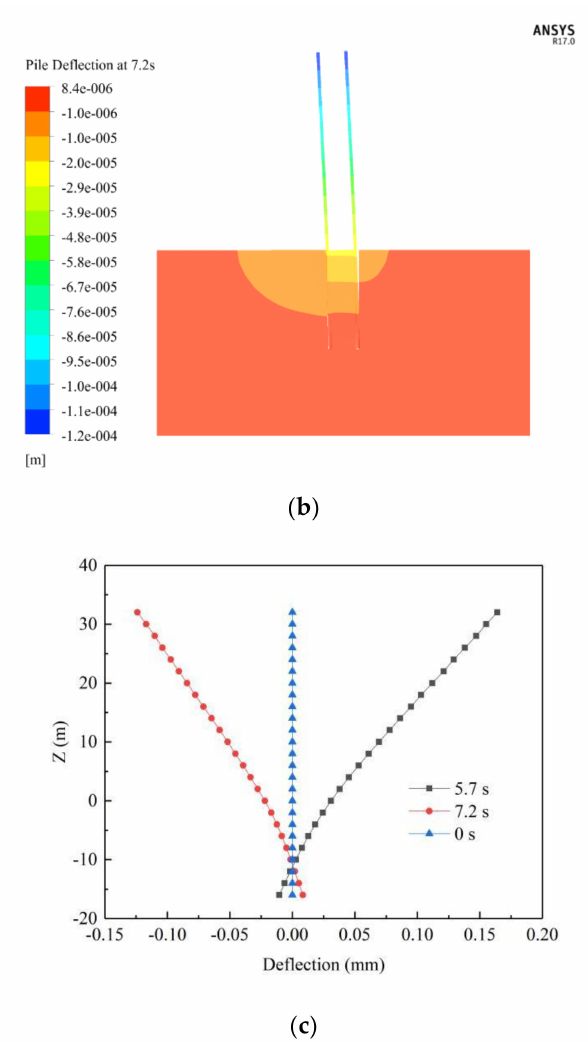
Figure 7. Deflection of the whole monopile body ( a ) at 5.7 s ( b ) at 7.2 s ( c ) distribution along pile length.